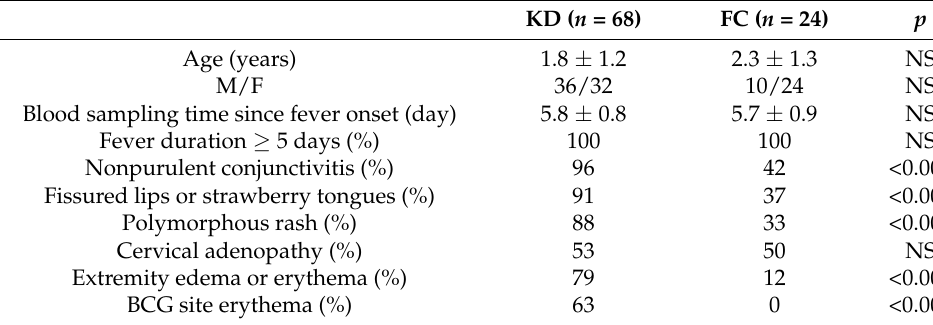
Table 1. The demographic data of subjects.